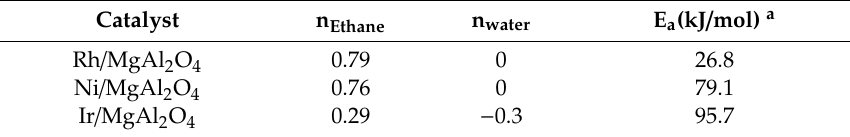
Table 3. Kinetic parameters calculated for ethane steam reforming reaction at 600 ◦ C.